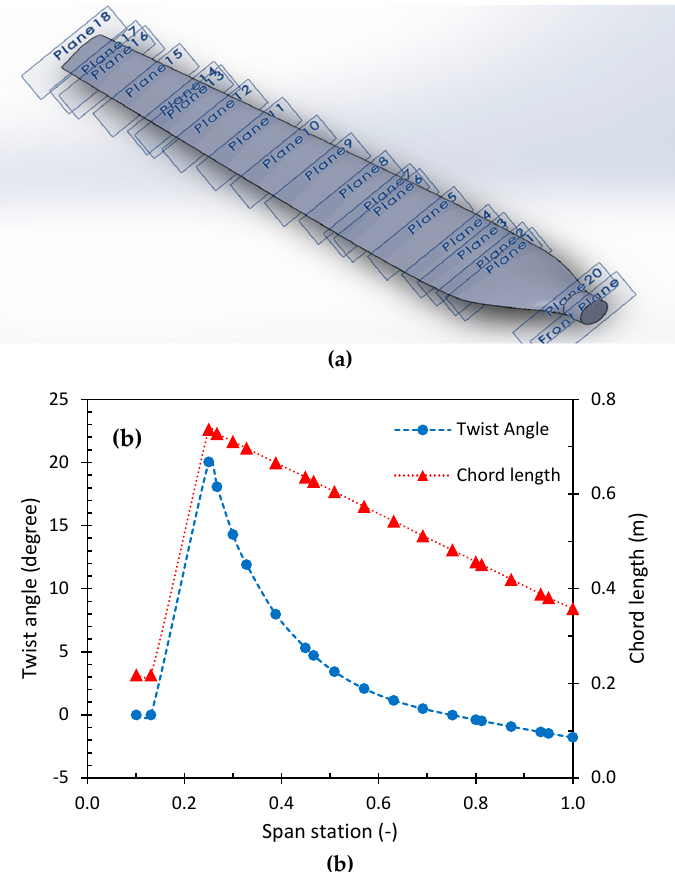
Figure 1. ( a ) A 3D geometry model of a 20 kW wind turbine blade. ( b ) The chord and twist distribution along the span of the blade.